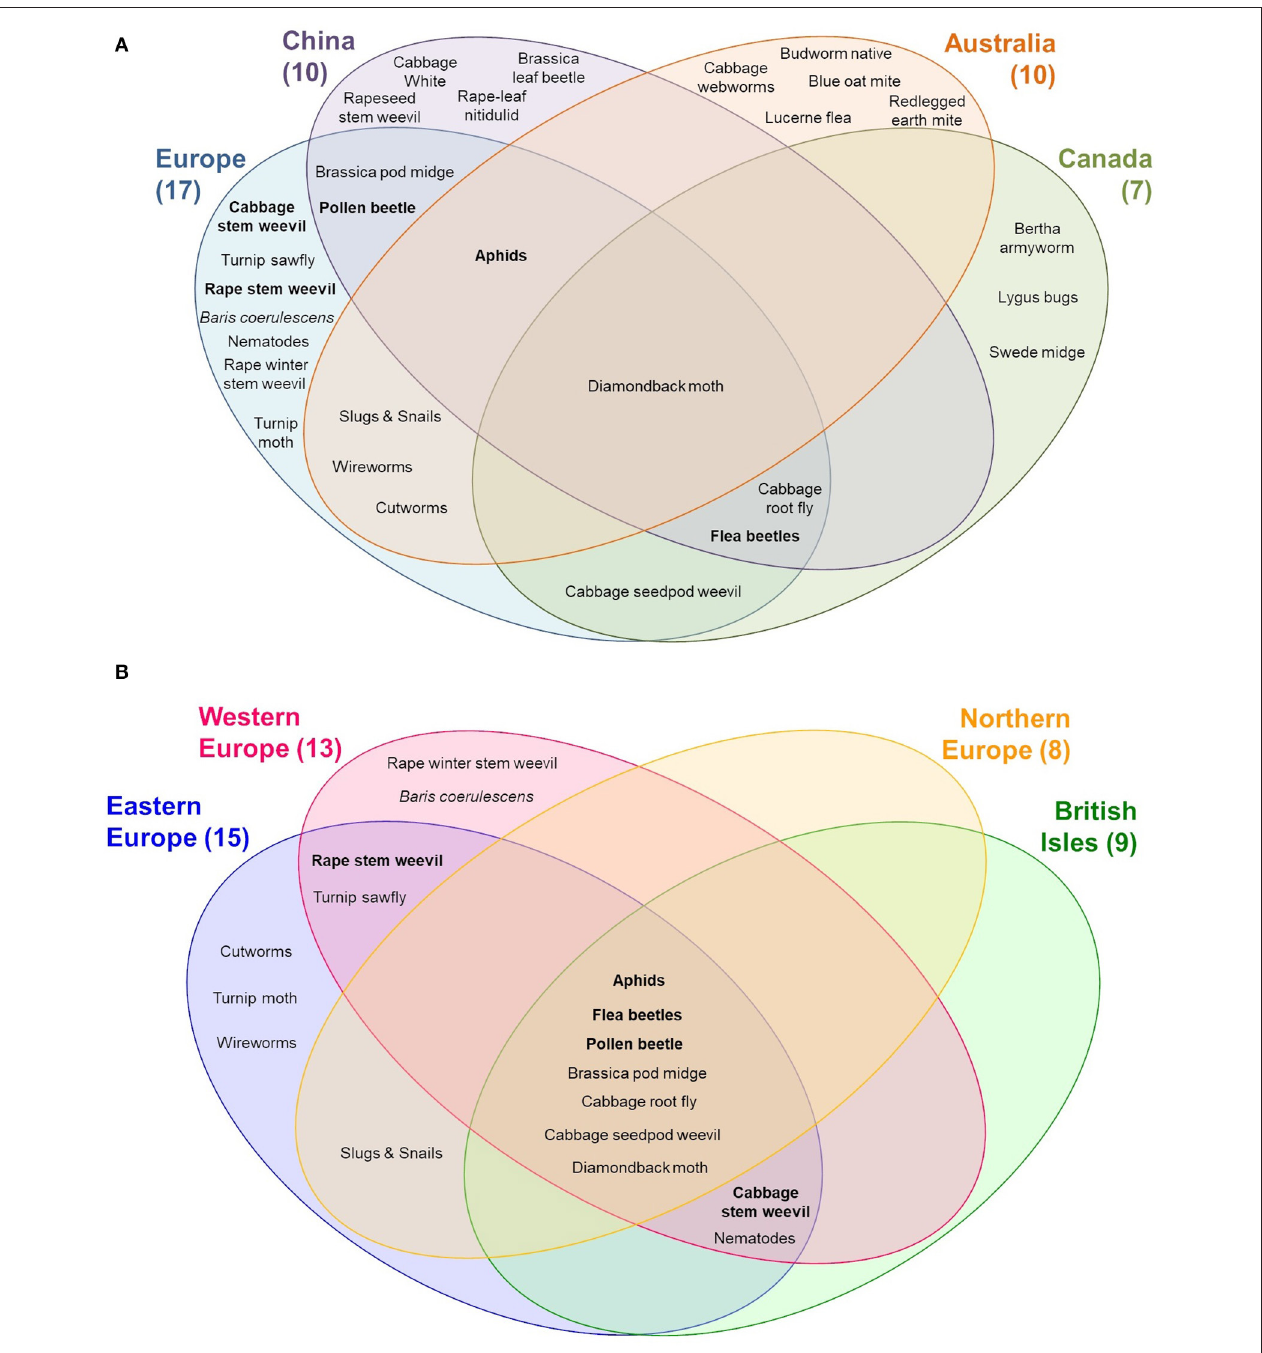
FIGURE 3 | Distribution of important pests on oilseed rape worldwide (A) and in Europe (B) . Top 10 pests in the worldwide are marked in bold